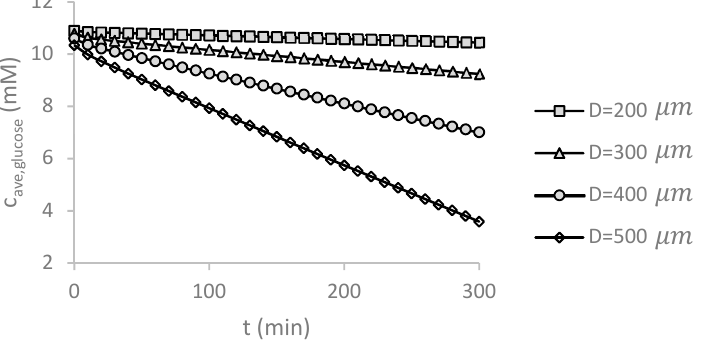
Figure 11. The average glucose concentration inside the spheroid changes over time for different spheroid diameter D without supplying the culture medium. For small spheroids, the temporal changes of inlet concentration of glucose are marginal. As the diameter of the spheroid increases, the cells consume more glucose over time and the continuous perfusion of the culture medium becomes essential to avoid necrosis. The simulations were carried out for Q initial = 5 µ L/min and c 0, glucose = 11 mM .